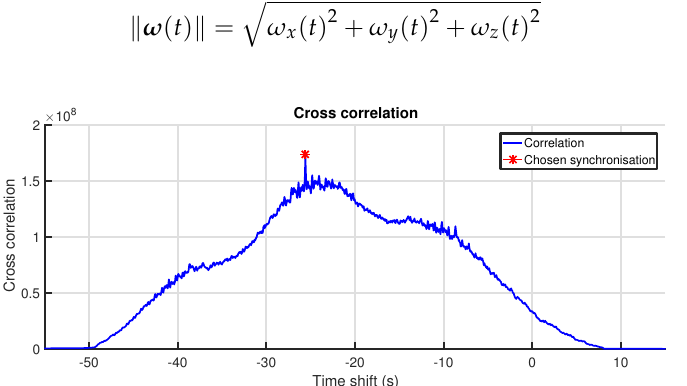
Figure 11. Example of the cross-correlation between angular velocity magnitude between IMU and optical motion capture (OMC).